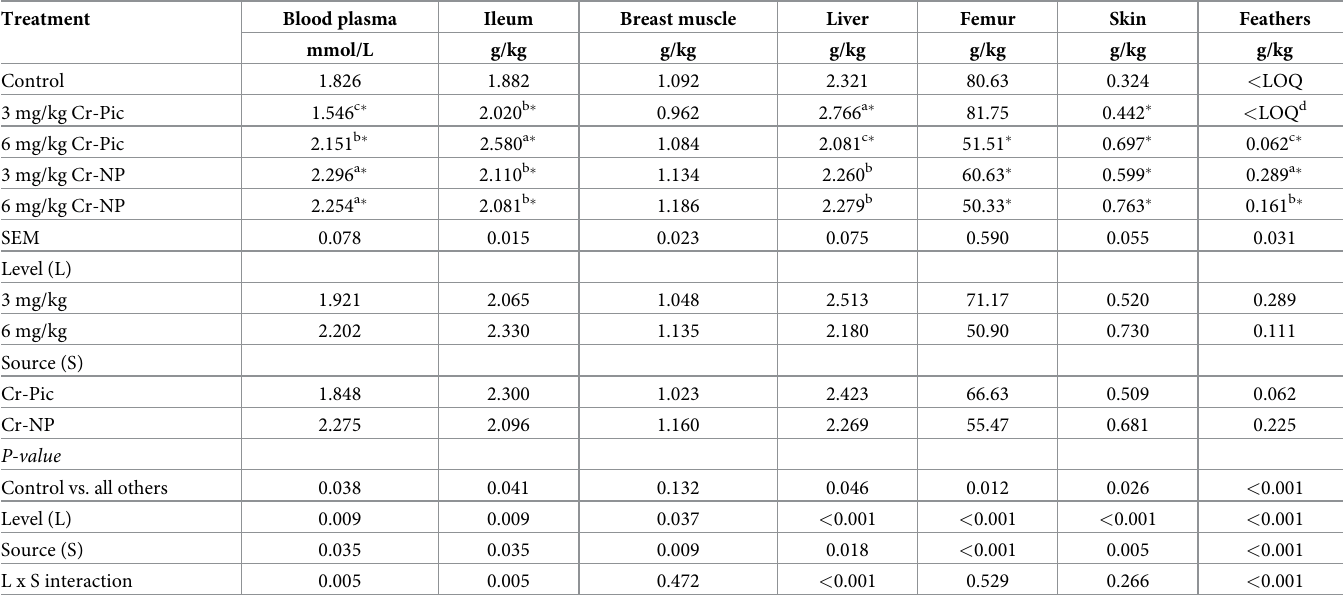
Table 4. Content of phosphorus in selected tissues and feathers.